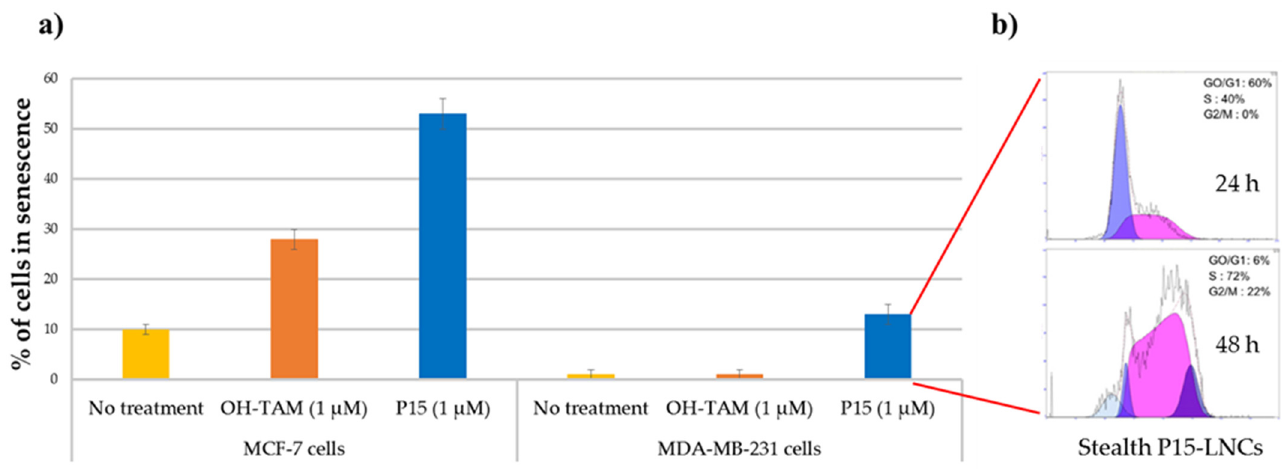
Figure 6. ( a ) Percentage of cells in senescence obtained by SA-galactosidase staining, 5 days after treatment on MCF-7 cells and MDA-MB-231 cells (no treatment as control in yellow; OH-TAM at 1 µM in orange; P15 at 1 µM in blue); ( b ) flow cytometric analysis profile of the MDA-MB-231 cell cycle 24 and 48 h after stealth P15-LNC treatment. A cell cycle arrest in S phase was observed corresponding to a senescence phenomenon (adapted with permission from [54,55], Copytight 2021 Elsevier).